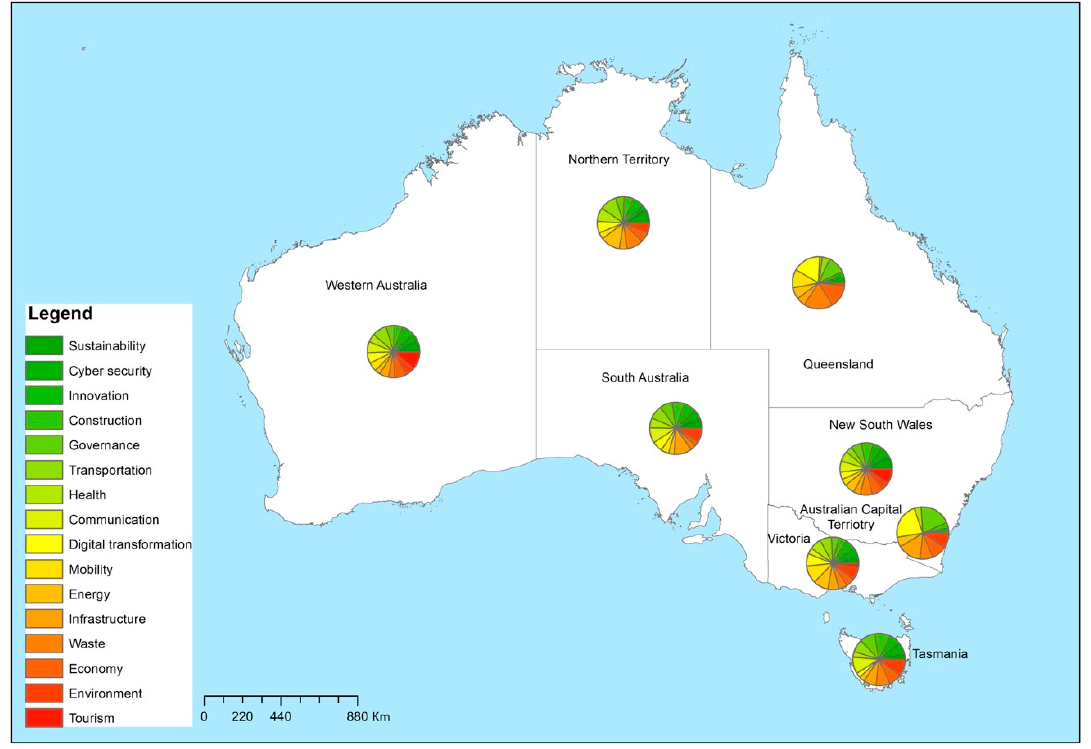
Figure 4. Distribution of tweets by urban planning and development concepts per state/territory.